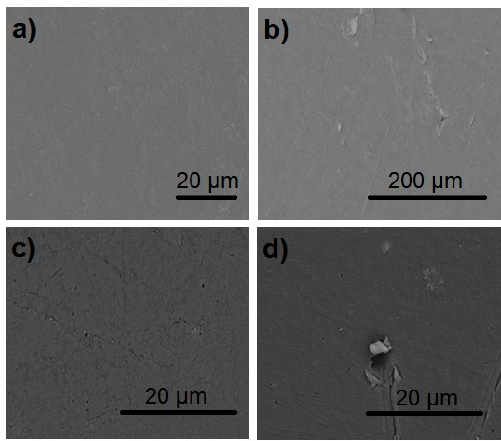
Figure 7. Scanning electron microscopy (SEM) images of initial and photoaged PE and PE/SNp during 35 days of photoaging: ( a ) PE initial; ( b ) PE aged; ( c ) PE/CaCO 3 initial; and ( d ) PE/CaCO 3 aged.